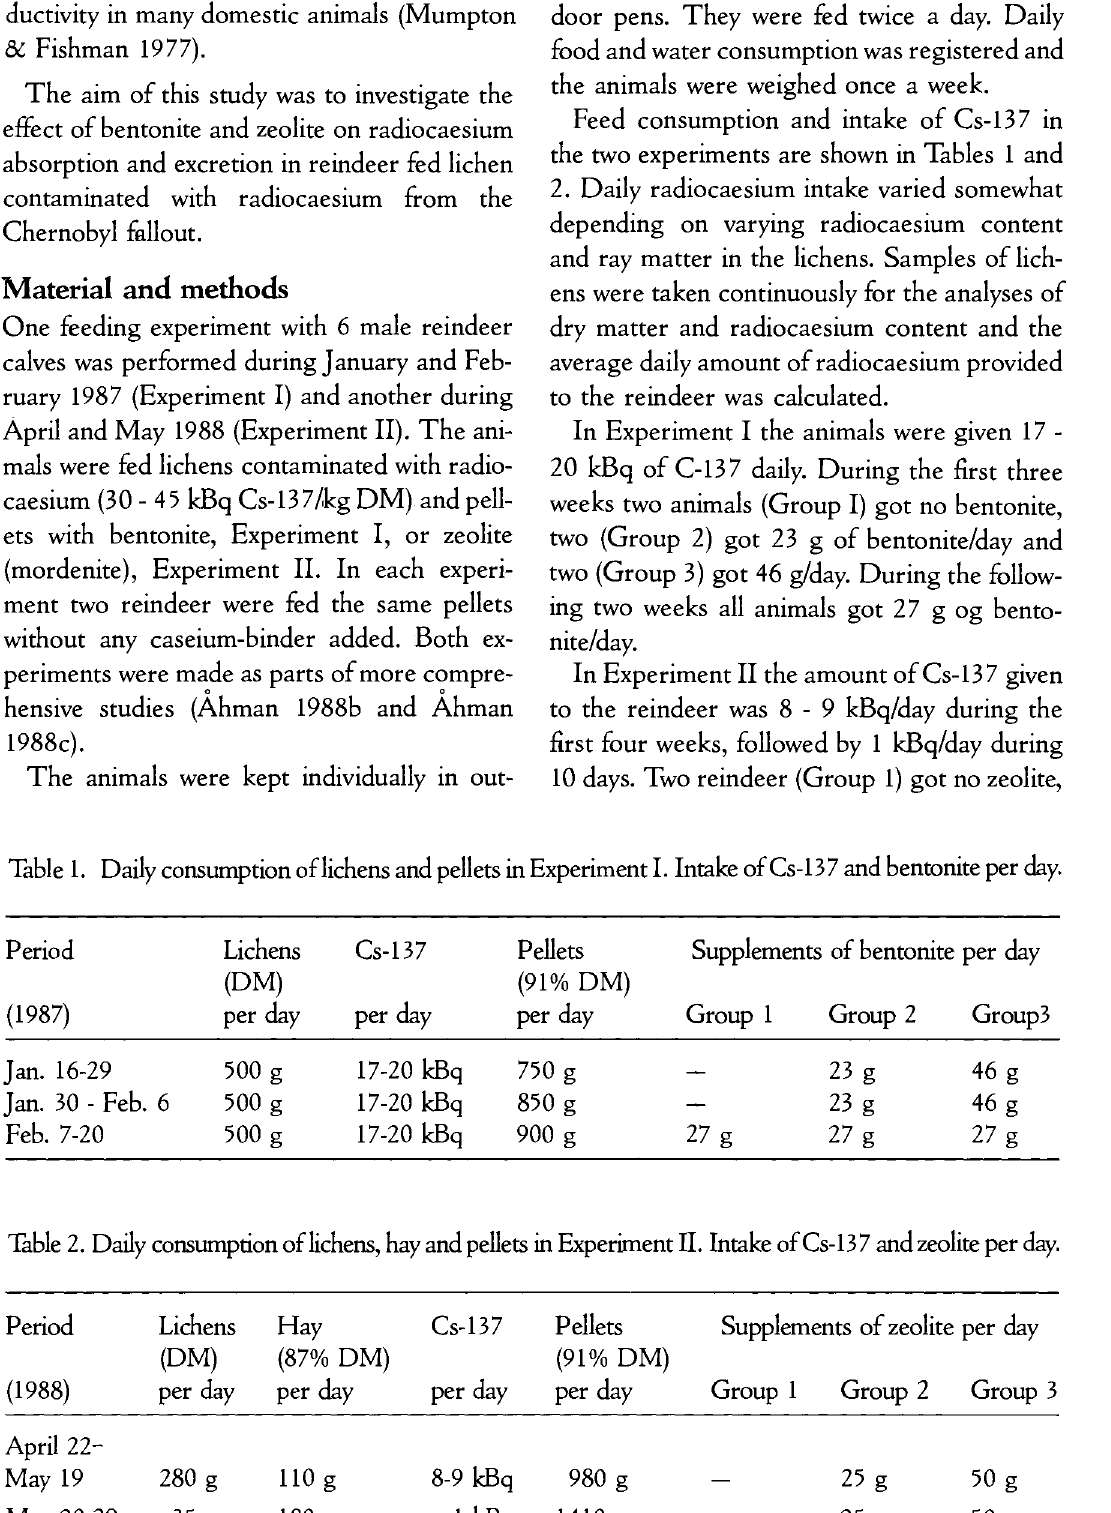
Table 1. Daily consumption of lichens and pellets in Experiment I. Intake of Cs-137 and bentonite per day. Period